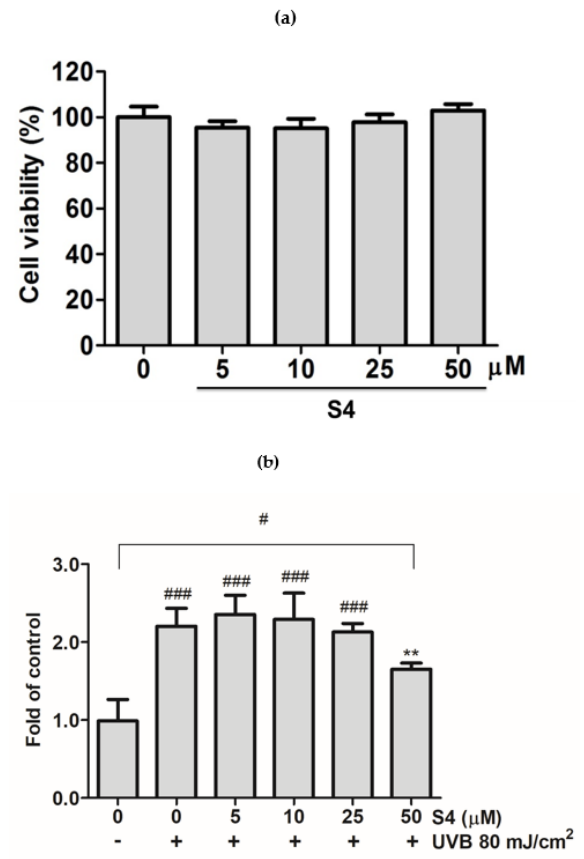
Figure 2. ( a ) Cell viability (%) of S4 in human skin fibroblasts. ( b ) E ff ect of S4 on intracellular oxidative stress in ultraviolet (UV)B-induced human skin fibroblasts. The results were given as mean ± standard deviation ( n = 3). Significant di ff erence versus non-irradiation group: ###, p < 0.001. Significant di ff erence versus non-treatment group: **, p <